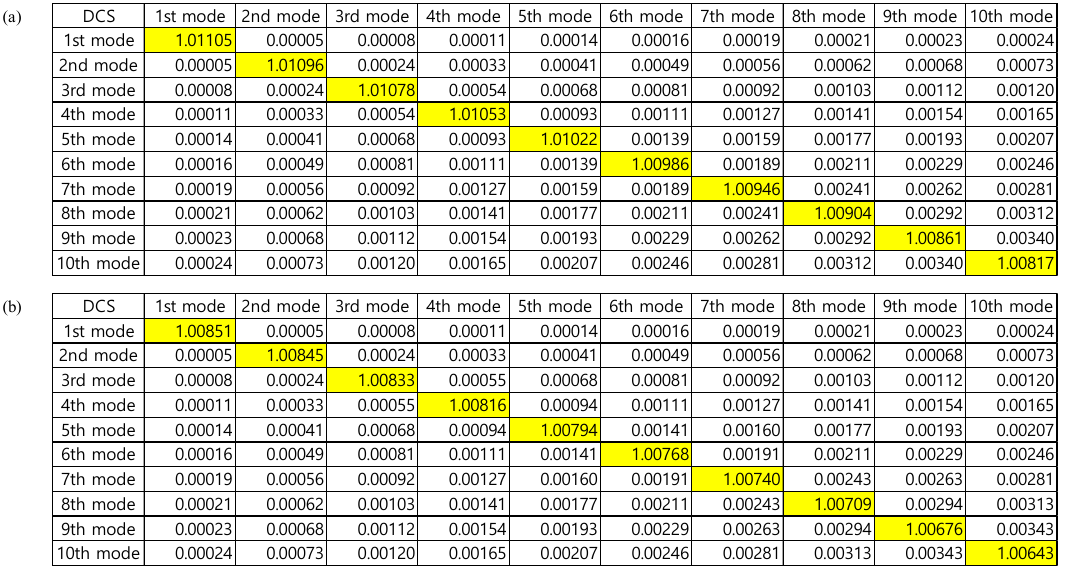
Figure 5. Orthogonal relationships among the first ten DCS modes for gap width 2 g = 4 nm: ( a ) ε r = – 14.88 and ( b ) ε r = –14.88 – j 0.39. The diagonal values are obtained from Equations (8) and (9) when n = m ( n = 1, 2, …, 10), and the off-diagonal values are obtained from Equations (8) and (9) when n ≠ m . Note: Cells highlighted in yellow indicate that the numerical values of the diagonal cells approach 1.